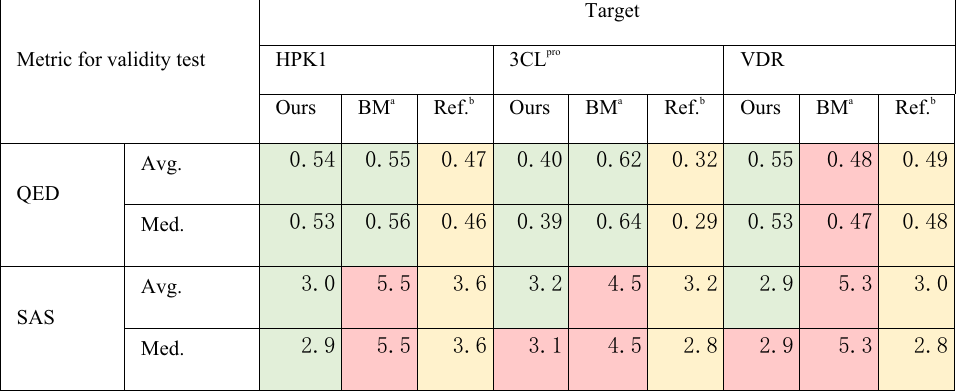
Table 1. Evaluation of molecular validity. 10,000 molecules each were generated by our model and the benchmark model for each target; a BM refers to a model 27 reported in NeurIPS 2021 and used as the benchmark here; b Reference compounds (Supporting information Table S1); Regarding the color scheme: all the values of reference compounds have their cells colored yellow. For generated molecules, if their values are better than or equal to that of the reference, then their cells are colored green; otherwise, their cells are colored red. Specifically, for QED, higher values are better; for SAS, lower values are